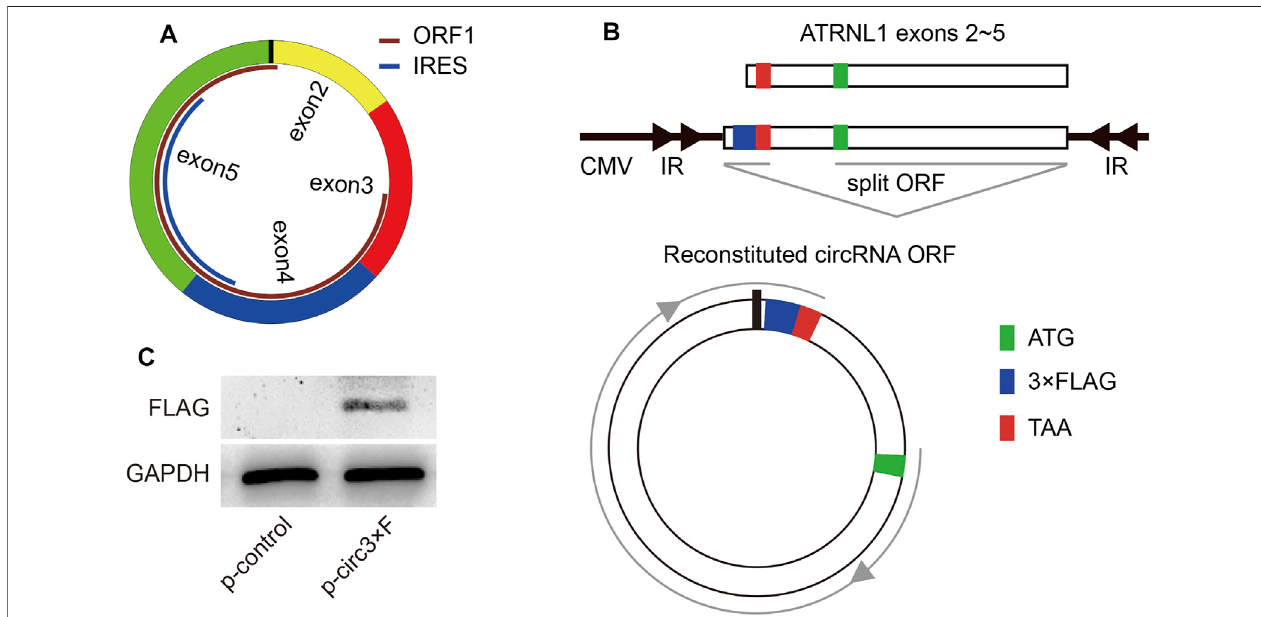
FIGURE4| circATRNL1encodesaprotein. (A) circPrimer2.0indicatesthatcircATRNL1containsanopenreadingframe(ORF)andaninternalribosomeentrysite (IRES). (B) Schematic representation of the p-circ3×F construct. IR, inverted repeats. (C) Western blot analysis with an anti-FLAG antibody on proteins from cells transfected with p-circ3×F or p-control (control